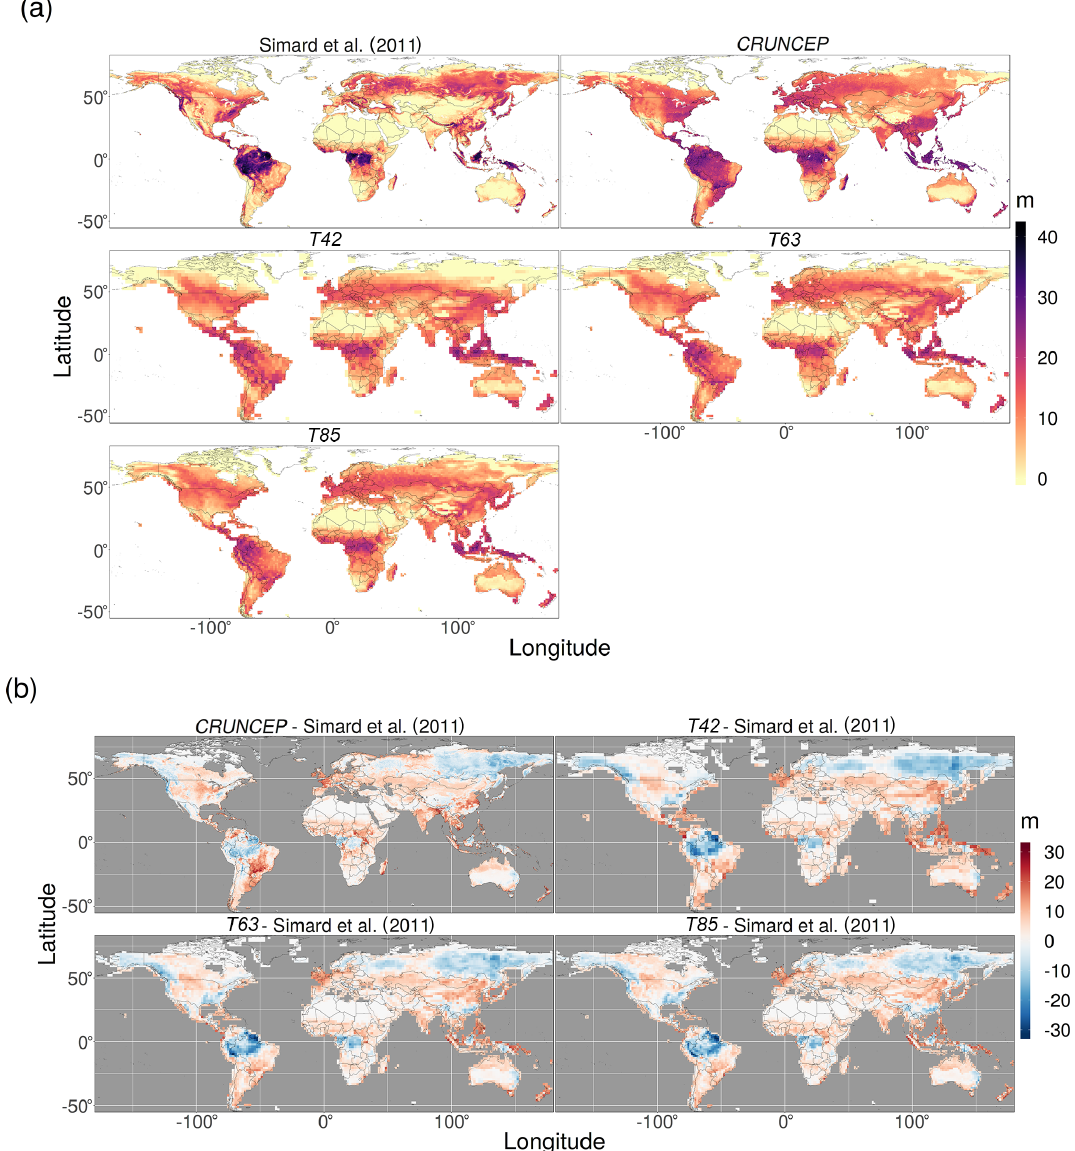
Figure 6. Comparison of canopy height from the T42 , T63 , and T85 (EMAC climate) and CRUNCEP (observed climate) simulations with observed canopy height from Simard et al. (2011); (a) absolute values and (b) the difference between simulations minus